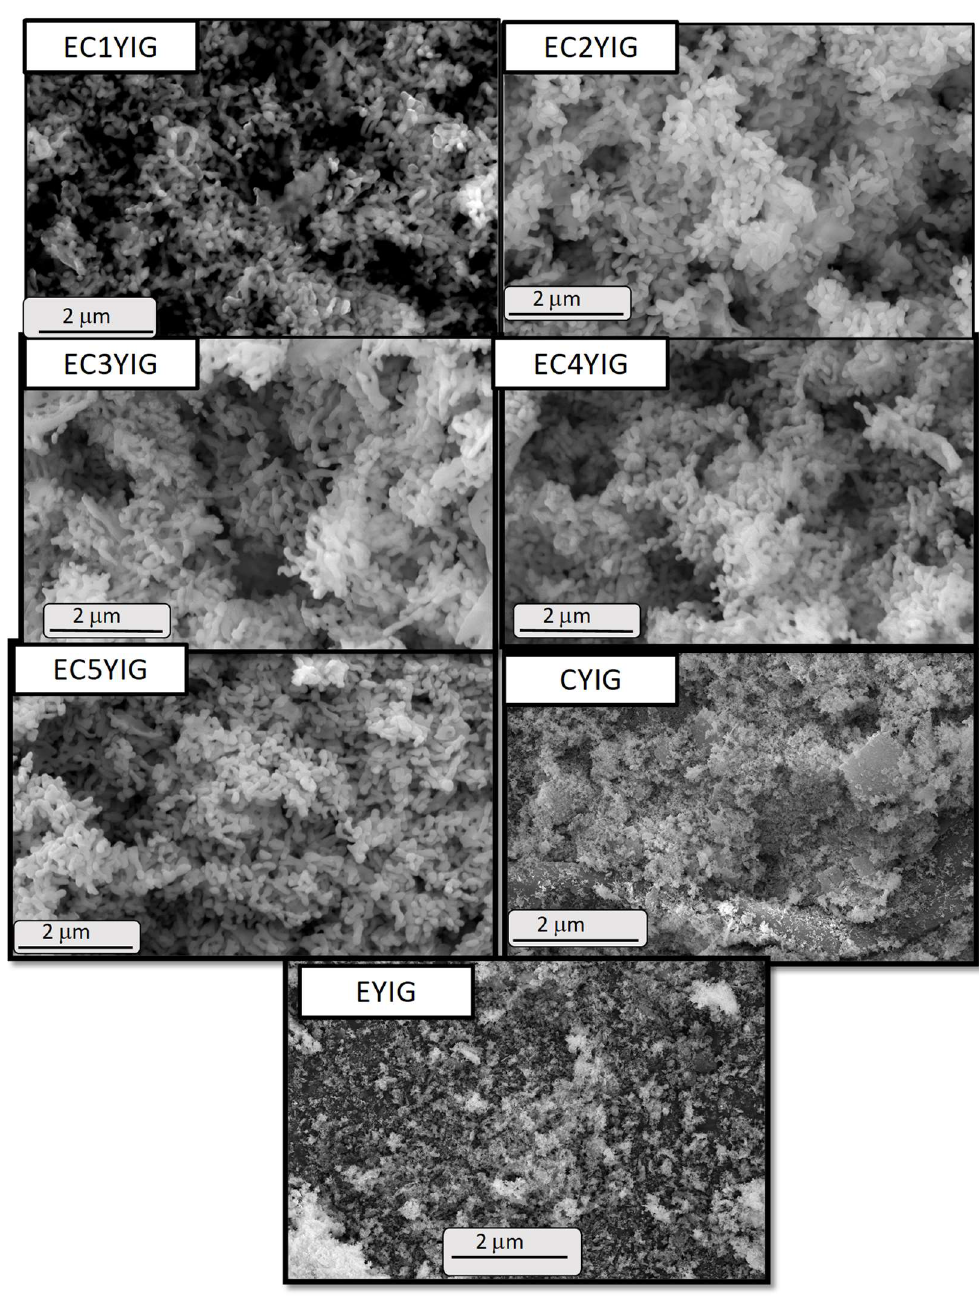
Figure 6. SEM micrographs of the spent yttrium iron garnet ferrites. Reaction conditions: EB to H 2 O 2 molar ratio of 1 using 1.3 mol of acetone as solvent, temperature of 50 °C and a catalyst mass of 50 mg within 360 min of reaction.